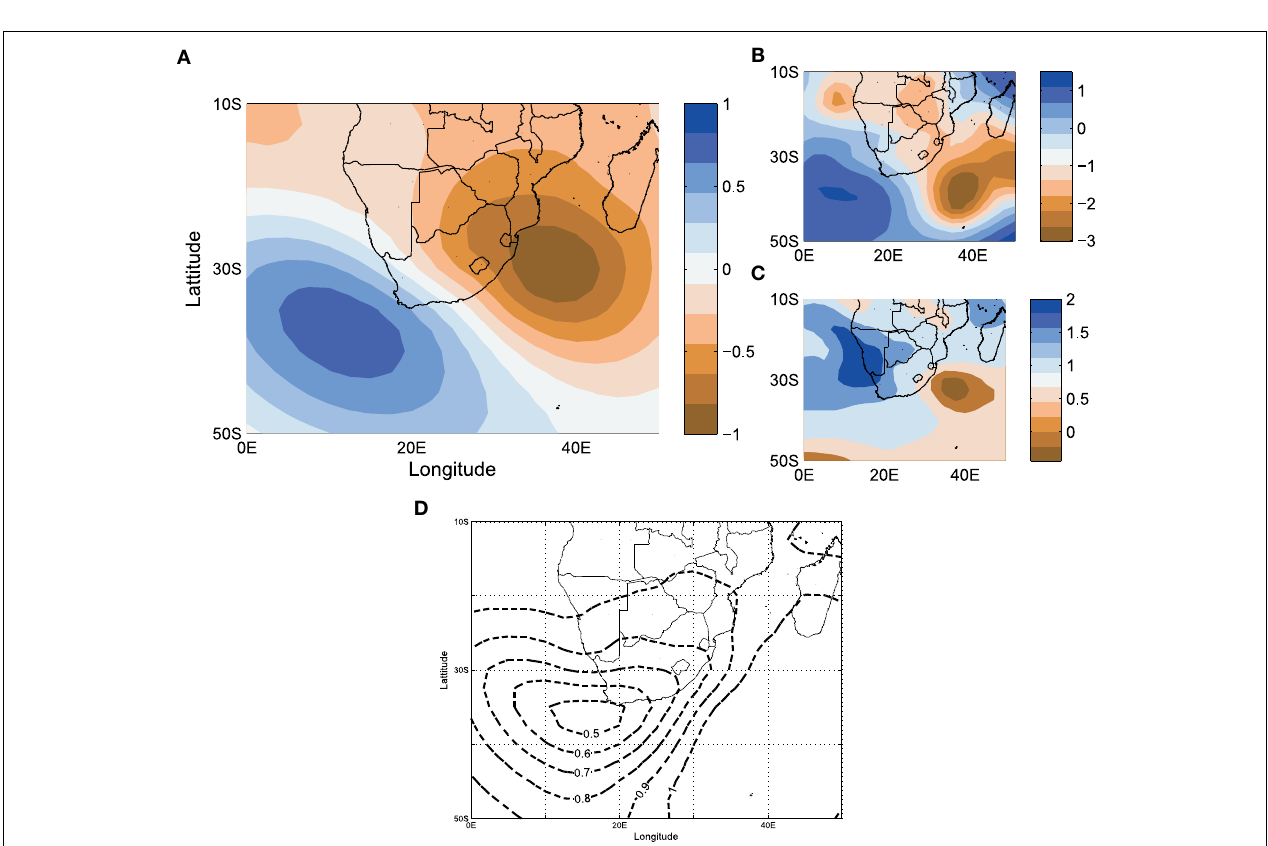
FIGURE 6 | Average anomaly pattern for CP03 (A) showing (B) the anomaly with highest DOF, (C) the anomaly with lowest DOF value, and (D) the standard deviation for all CP03 anomalies.